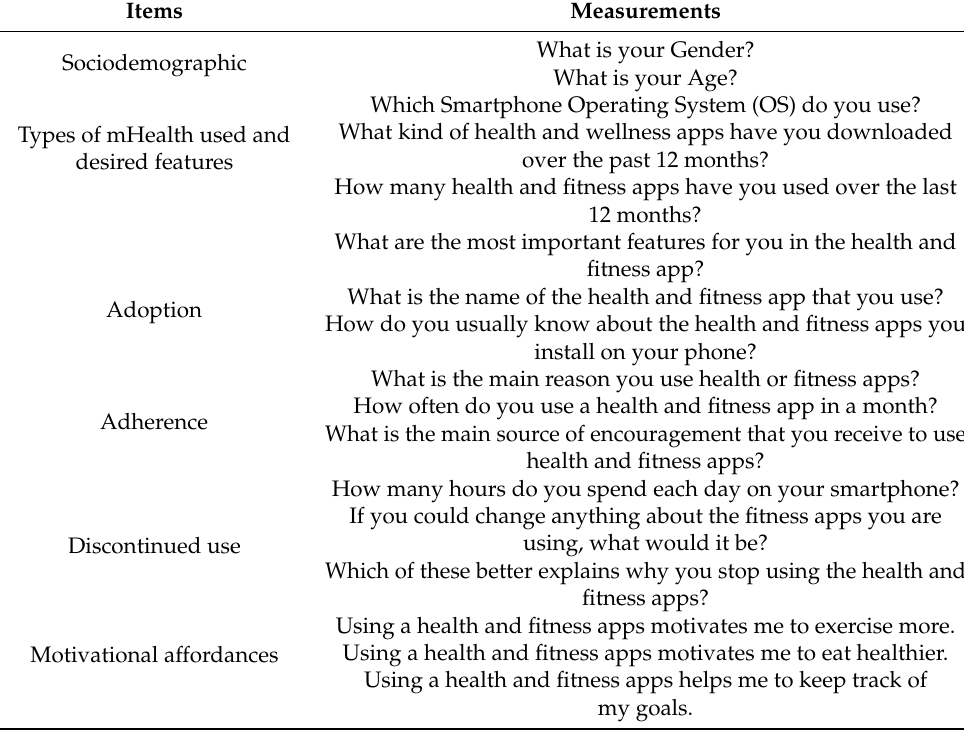
Table 1. Survey measurement items (adapted from